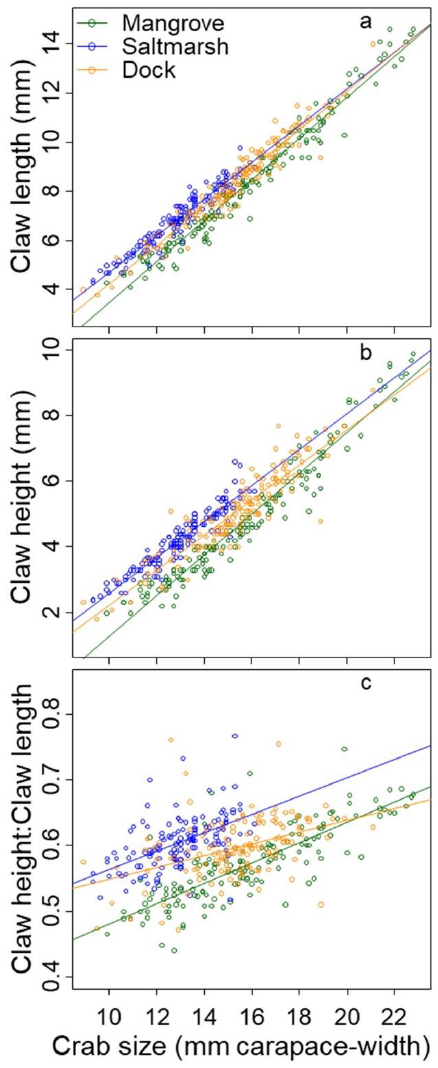
Figure 3. Relationships between A. pisonii size and ( a ) claw length, ( b ) claw height, and ( c ) claw- height:claw-length